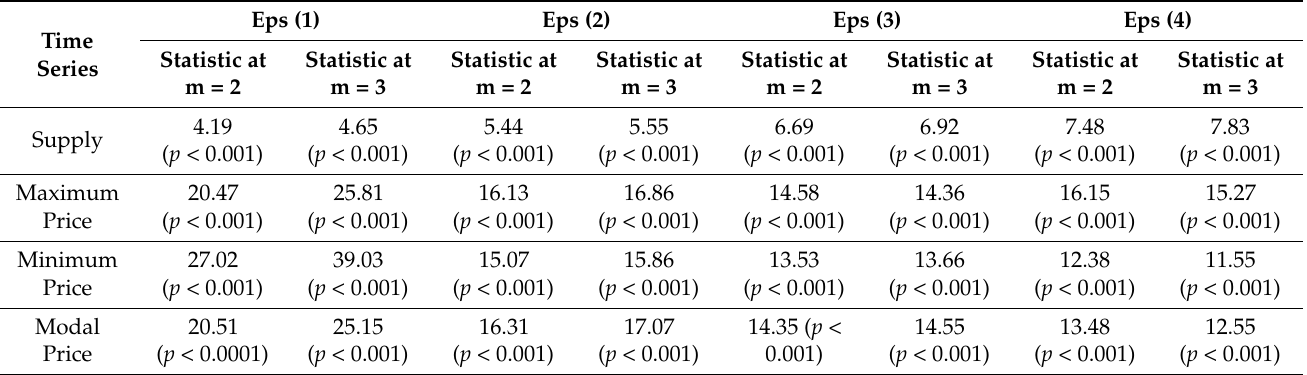
Table 2. BDS test for